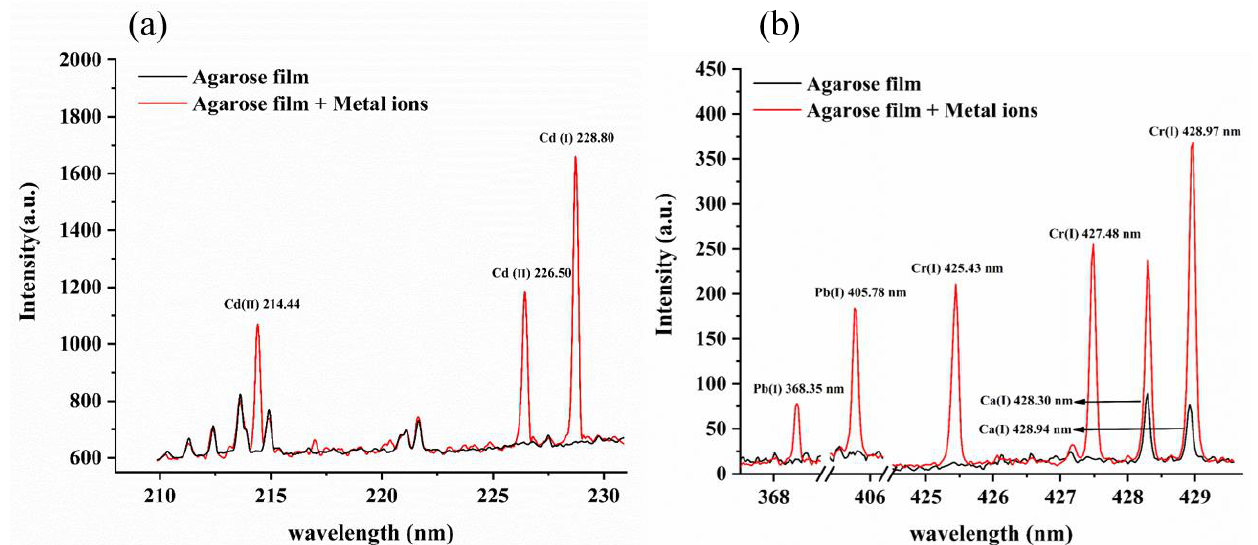
Figure 3. The LIBS spectra of agarose film blank and agarose film samples prepared by 1.25 mg L −1 metal ion solution collected by spectrometer SR-500i-A-R ( a ) and spectrometer ME5000 ( b ).